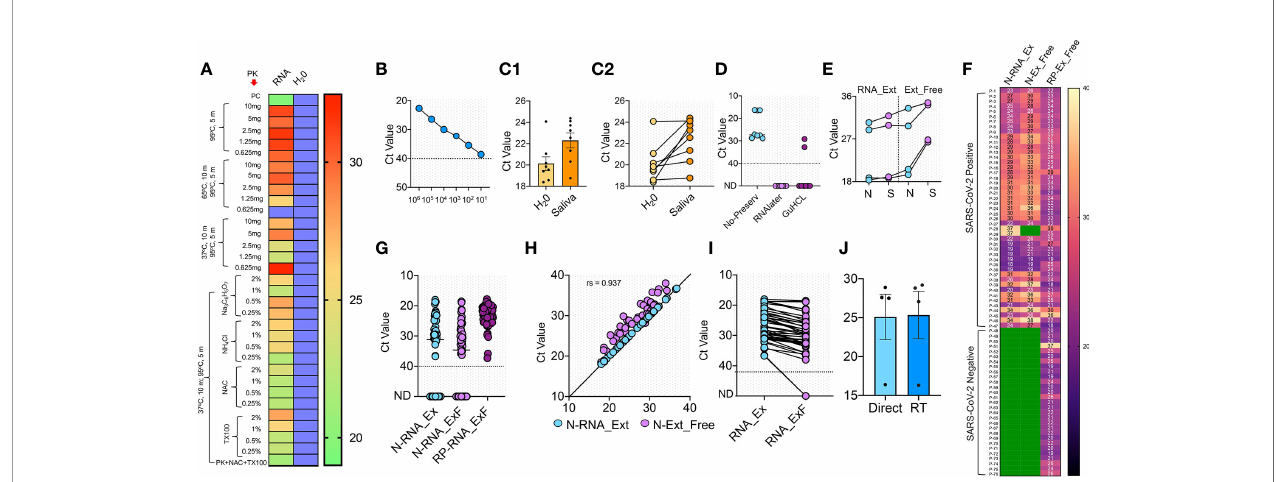
FIGURE 2 | RNA extraction-free detection of SARS-CoV-2 in saliva samples (A) Heat map of Ct values obtained with 10 5 copies of S gene standard RNA spiked into normal saliva and subjected to various heat inactivation and chemical treatments. PK: Proteinase K; NAC: N-acetyl cysteine and TX100: Triton X-100. Saliva samples with water was used instead of spiked-in RNA as negative control, which showed no detectable Ct value; blue boxes. (B) Standard curve showing various dilutions of S gene RNA spiked into normal saliva to obtain the LoD. (C1, C2) Comparison of Ct detected when S gene RNA was spiked into the saliva samples of eight SARS-CoV-2 negative volunteers vs the same spiked into water as control. (D) Optimization of various RNA storage agents like RNAlater, guanidinium hydrochloride (GuHCL) and without RNA storage agent for detection of SARS-CoV-2 in eight clinical saliva samples. (E) Comparison of N and S gene ampli fi cation in saliva samples after undergoing heat and chemical denaturation. (F) Heat map of Ct values obtained for N gene for 76 samples with RNA extraction (N-RNA_Ex) and RNA extraction-free (N-RNA_ExF) method. Human RNaseP (RP) was used as the experimental control to fi nd the RNA integrity of the samples used. Green boxes represent the samples with not detected Ct values. (G) Shows the individual Ct values of N-RNA-Ex and N-RNA_ExF along with the RNaseP with dotted line indicating lower level of detection. (H) Correlation of Ct values between N-RNA_Ex and N-RNA_ExF method (I) Median of Ct values of two methods as indicated by solid lines. The dotted line represents lower Ct value below which samples were labeled as not detected (ND). (J) Comparison of Ct values obtained from saliva samples when stored at room temperature (RT) for 6 h with same samples processed without storage